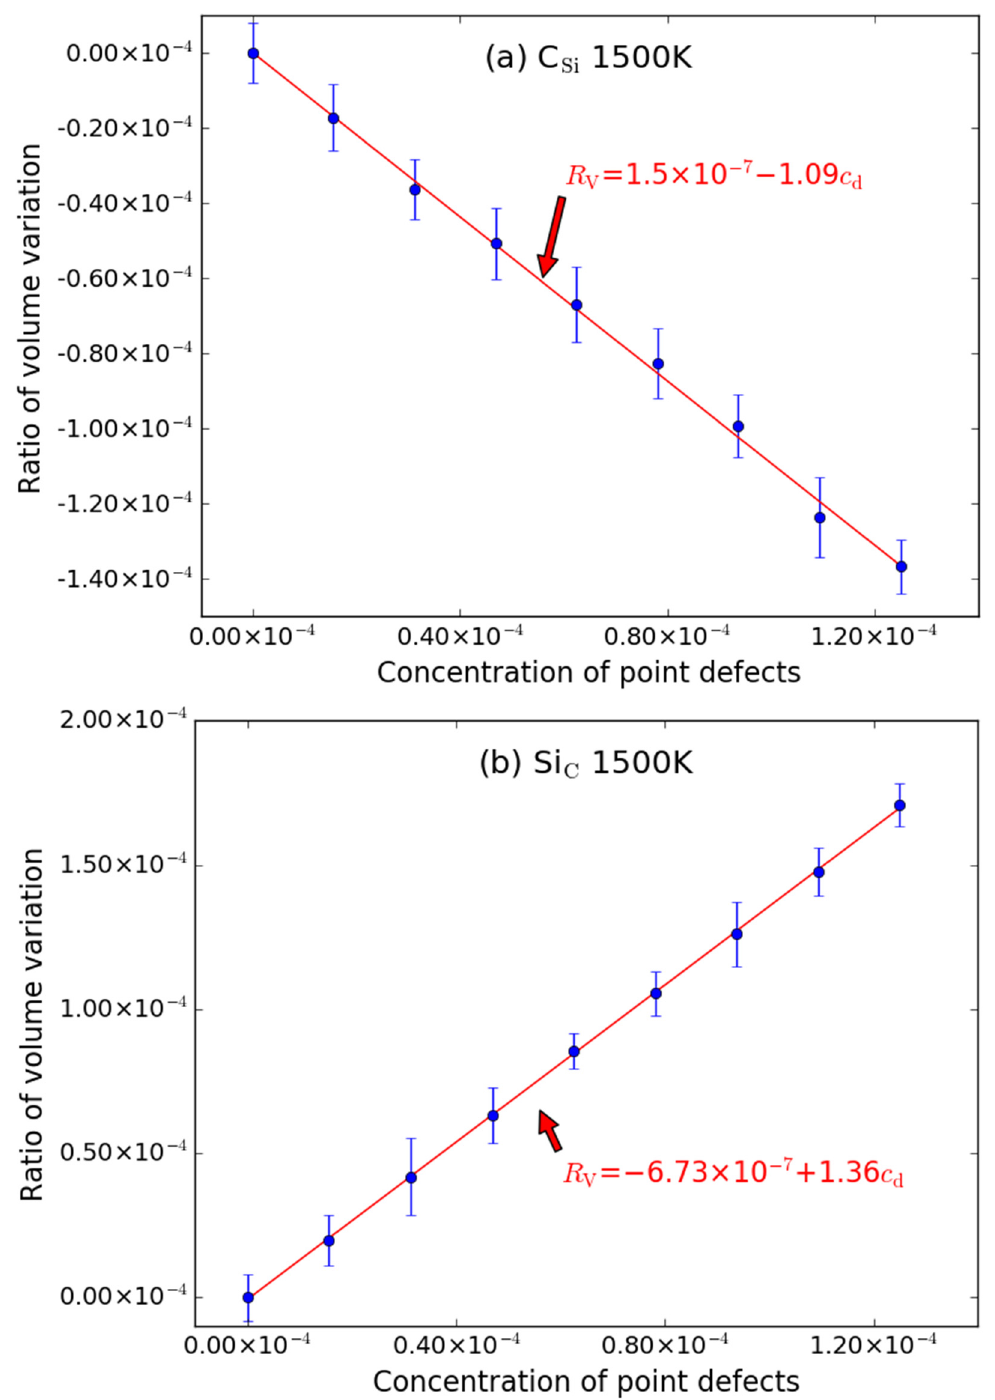
Figure 7. The ratio volume variation ( R V ) of the supercell caused by anti-site point defects (( a ) C Si and ( b ) Si C ) as function of concentrations ( c d ) of point defects at 1500 K. The error bars denote the standard deviations of the values. The size of supercell in MD simulation is 20 a × 20 a × 20 a .